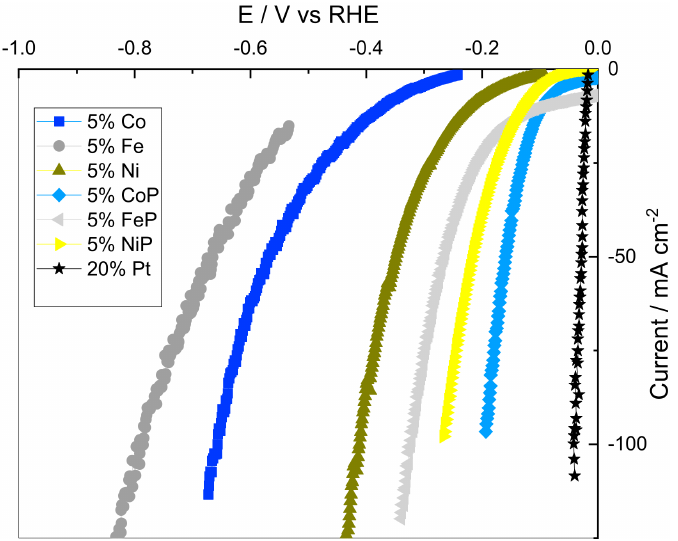
Figure 4. Cyclic voltammetry curves for the 5% metal content samples before and after the phospho- rization process, and the 20% Pt supported on CB.